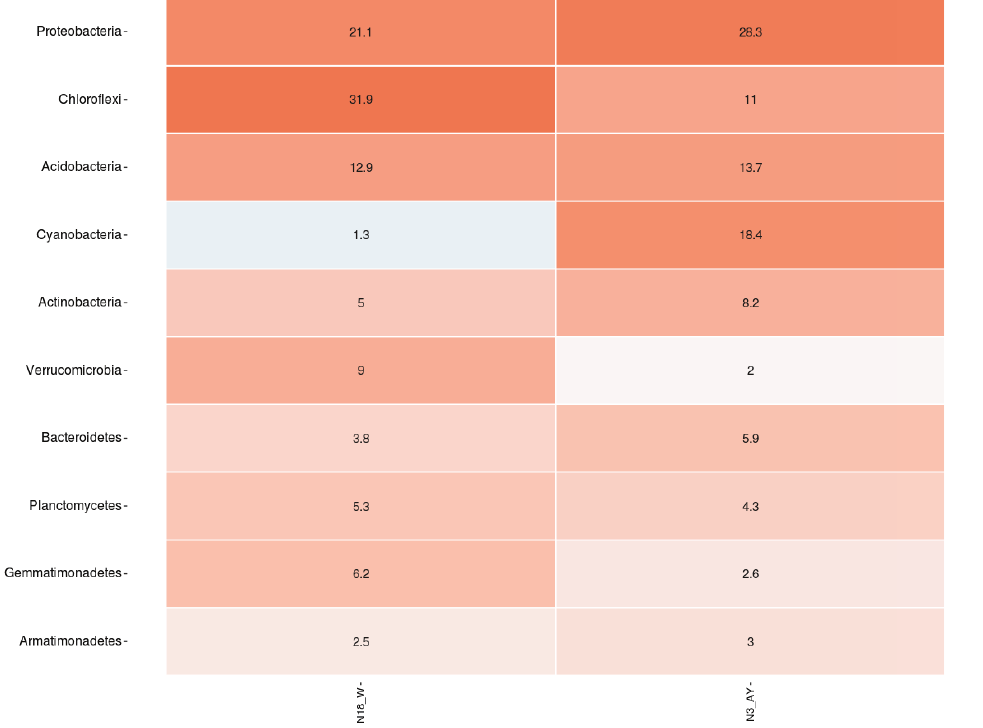
Figure 6: Top 10 phyla in N18_W and N3_AY samples. Numbers show percentage content of each phylum in a sample